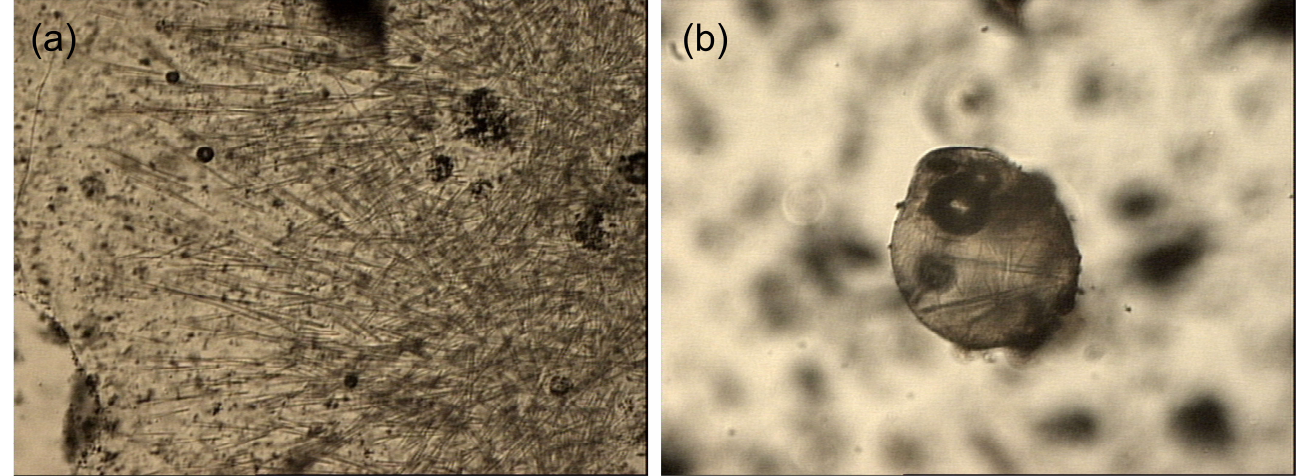
Figure 2. Microscope image inclusions of sillimanite rods in isotropic glass (transmitted light): ( a )